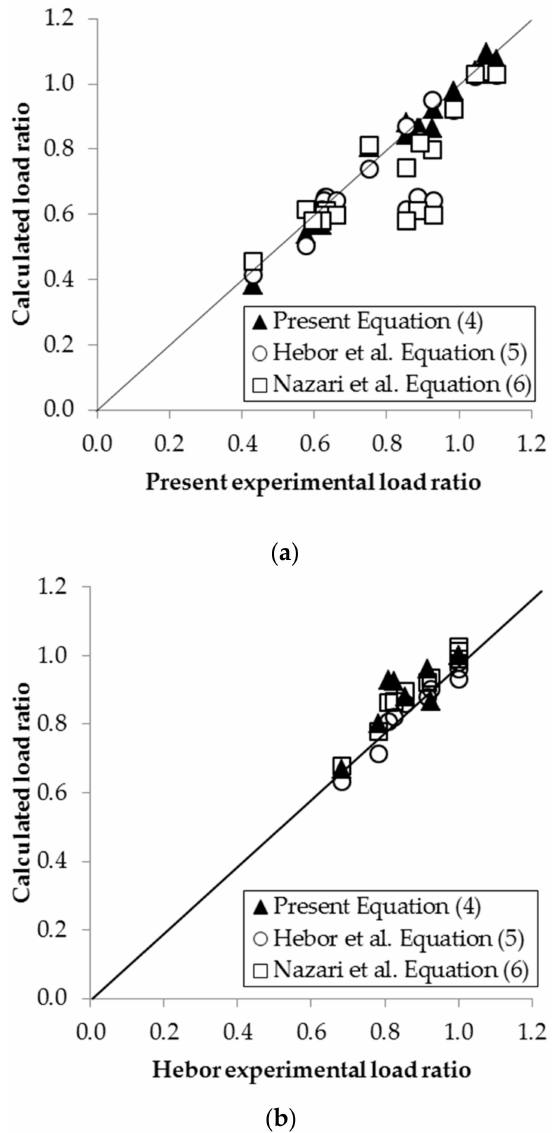
Figure 13. Comparison of experimental and calculated residual compressive strength: ( a ) Comparison of present experimental results versus calculated load ratio; ( b ) Hebor’s [1] experimental results versus calculated load